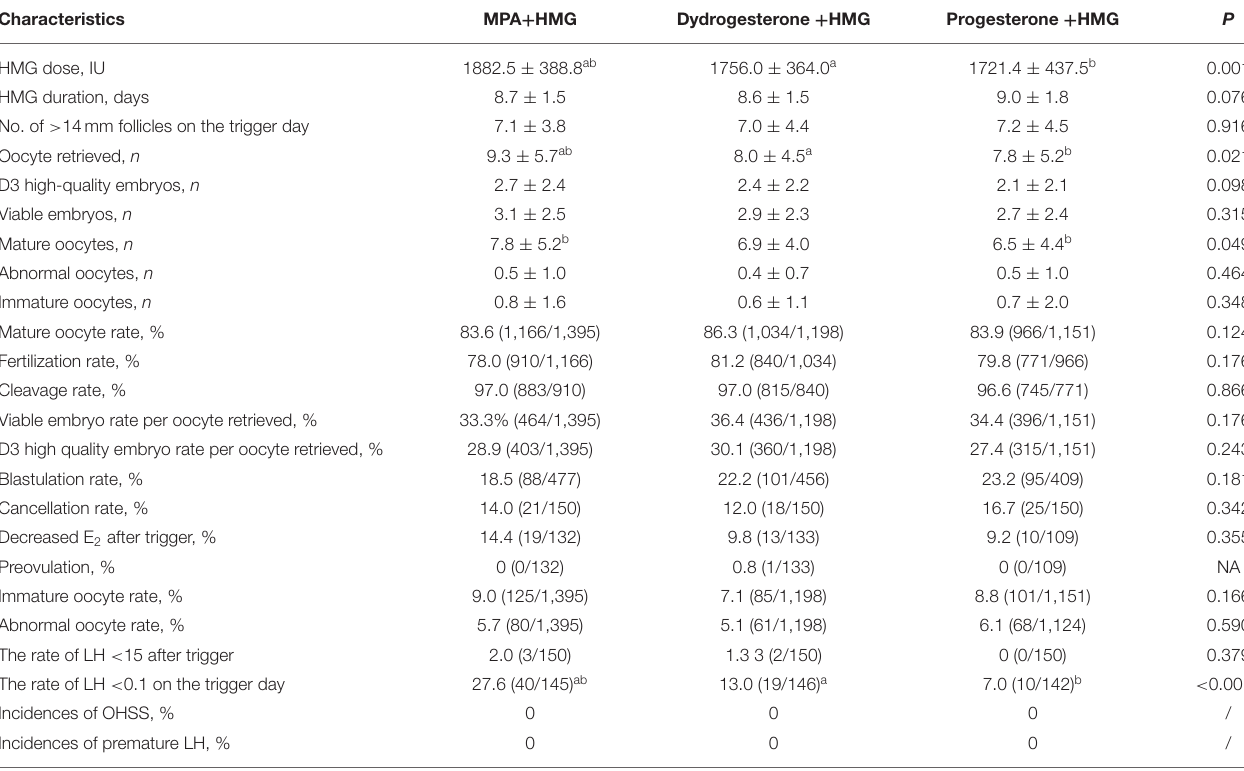
TABLE 2 | Stimulation and embryonic characteristics of the women in the three groups.